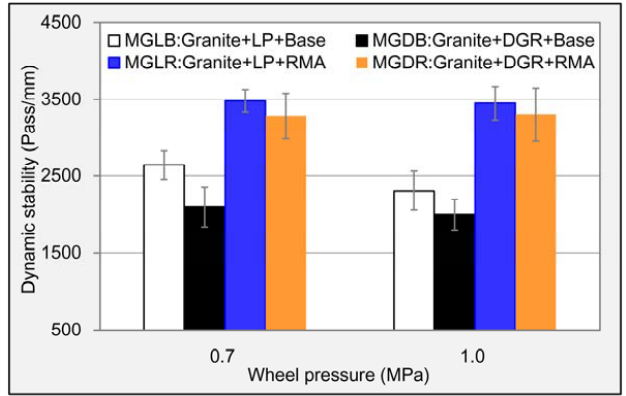
Figure 17. Dynamic stability results of different asphalt mixtures.